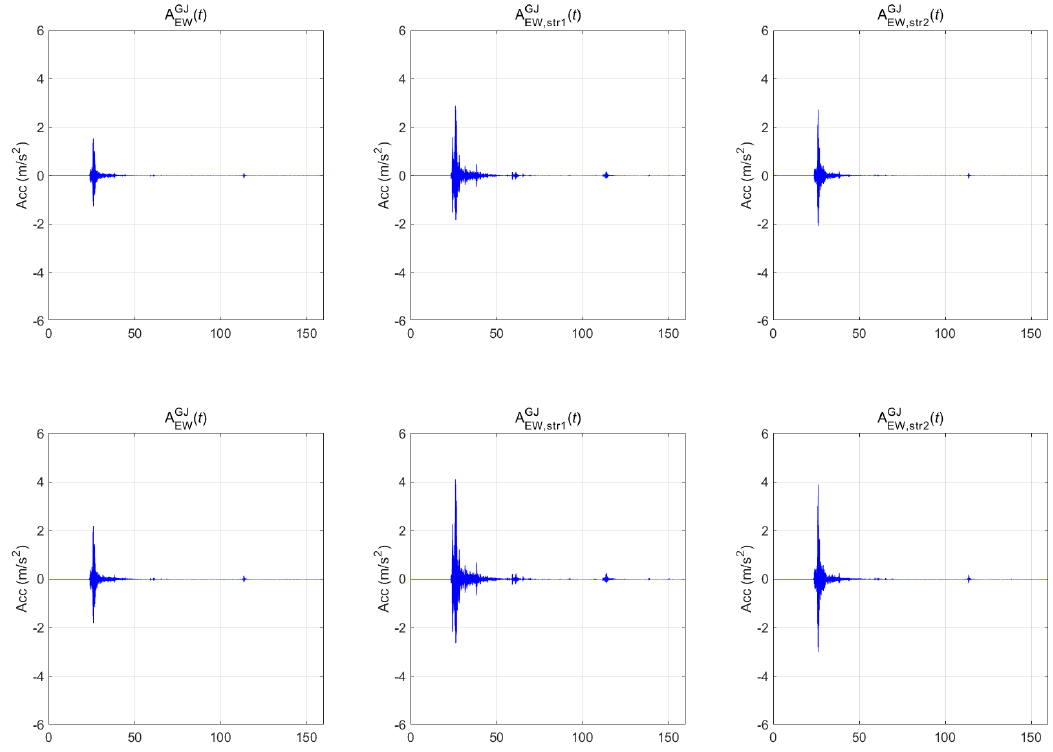
Figure 7. Bridge responses of the Gyeongju earthquake.